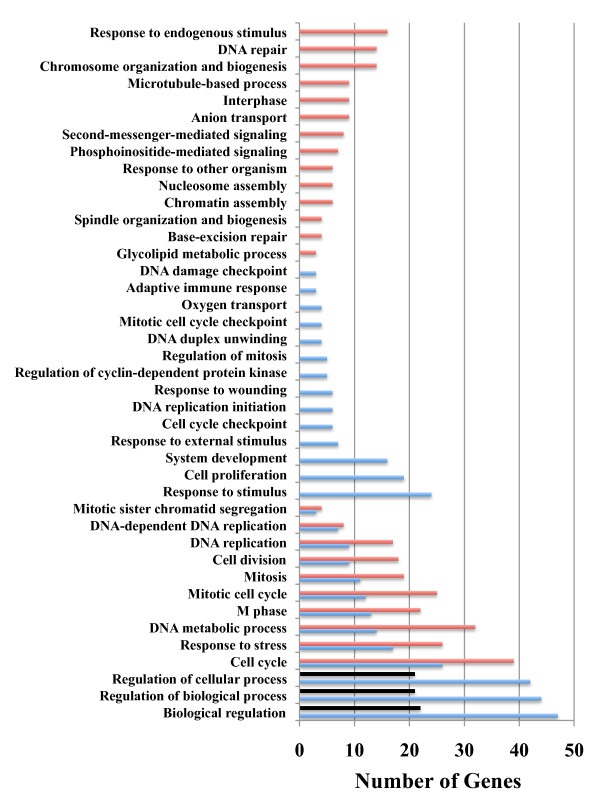
Gene ontology (GO) terms identified as significantly over-represented. The figure shows GO terms for differentially expressed genes (DEGs) identified uniquely from axolotls (black bars) and tiger salamanders (red bars), and GO terms for DEGs that were identified in common between the species (blue bars).